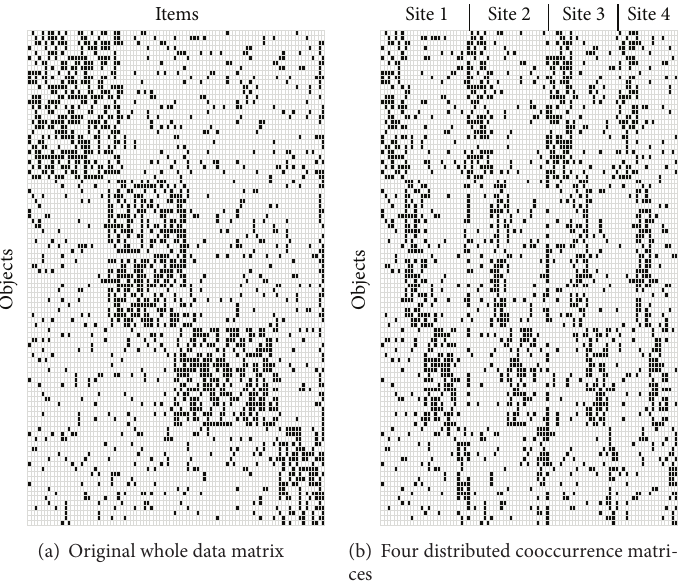
Figure 3: Artificially generated data with homogeneous cluster partition.